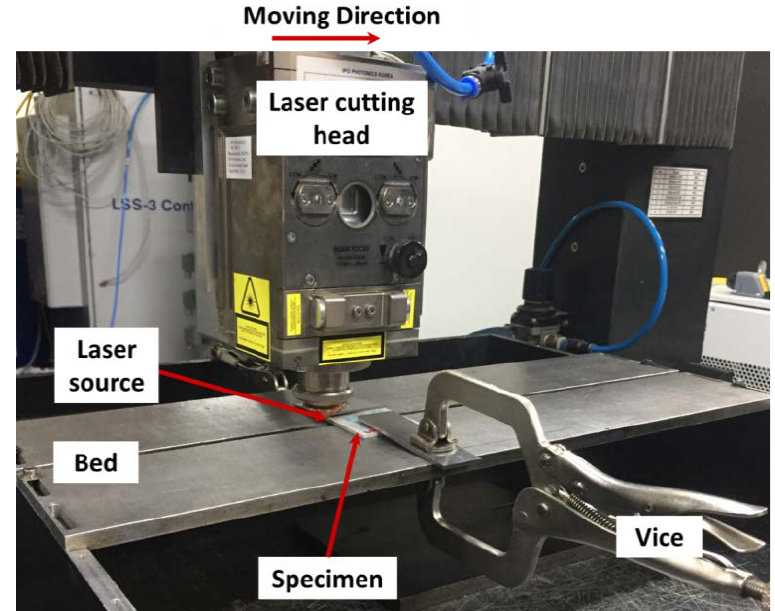
Figure 1. Experiment set-up.